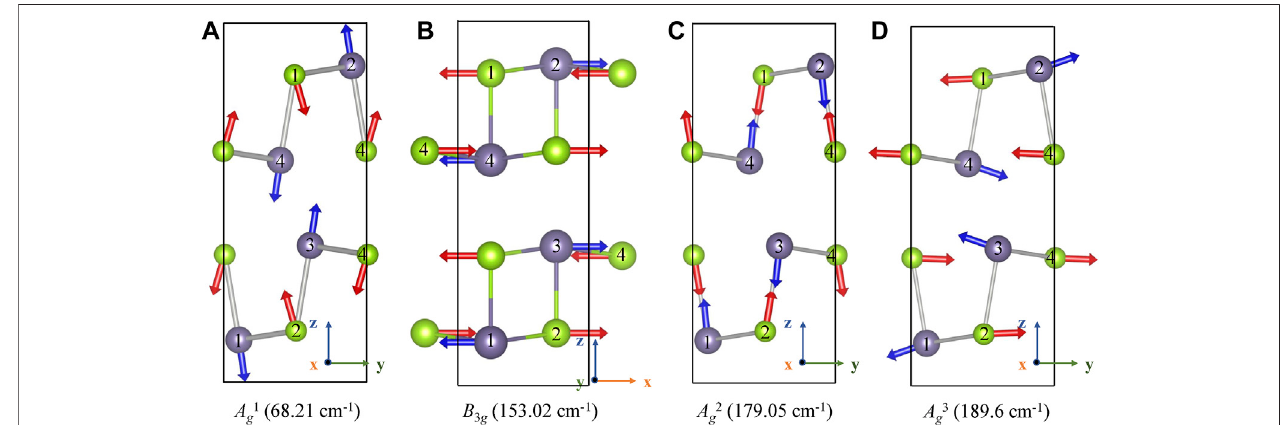
FIGURE 2 | The activate Raman vibration mode of bulk GeSe. The out-of-plane along z direction.